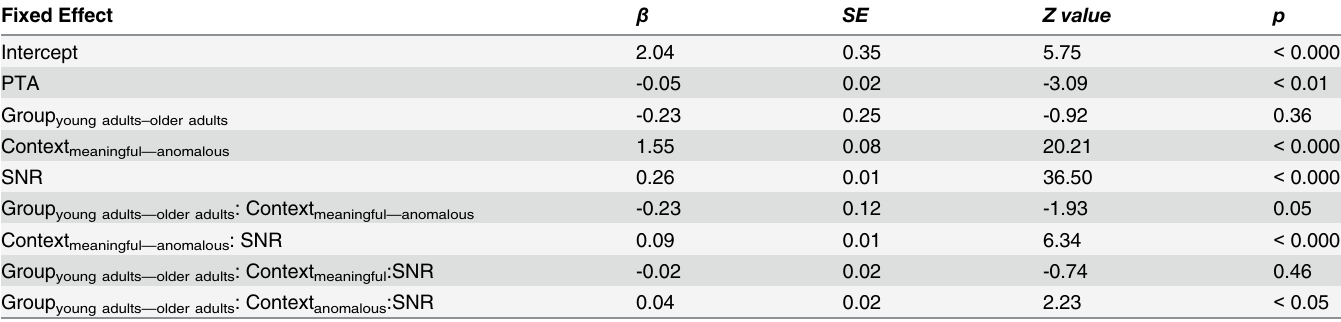
Table 4. Log odds of producing a correct response across group, context, and SNR in the audio-visual modality. Fixed